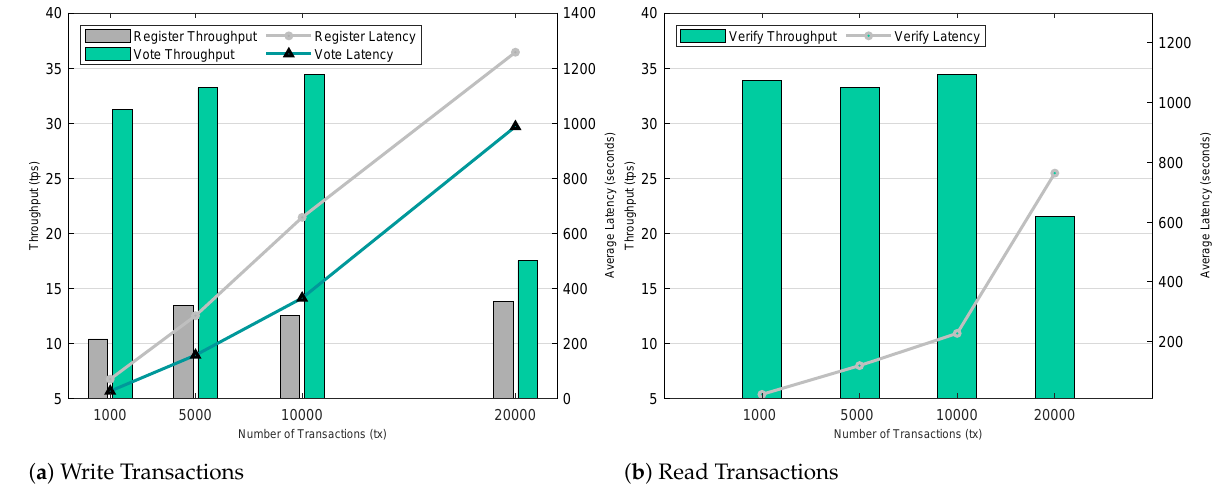
Figure 4. The impact of increasing the number of transactions on latency and